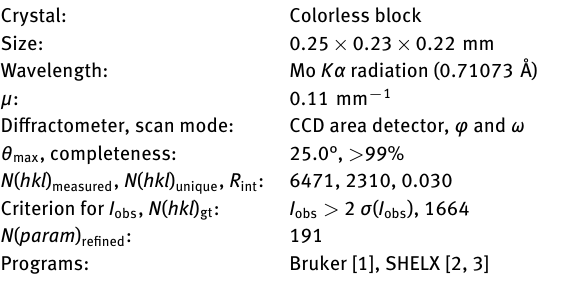
Table 1: Data collection and handling.